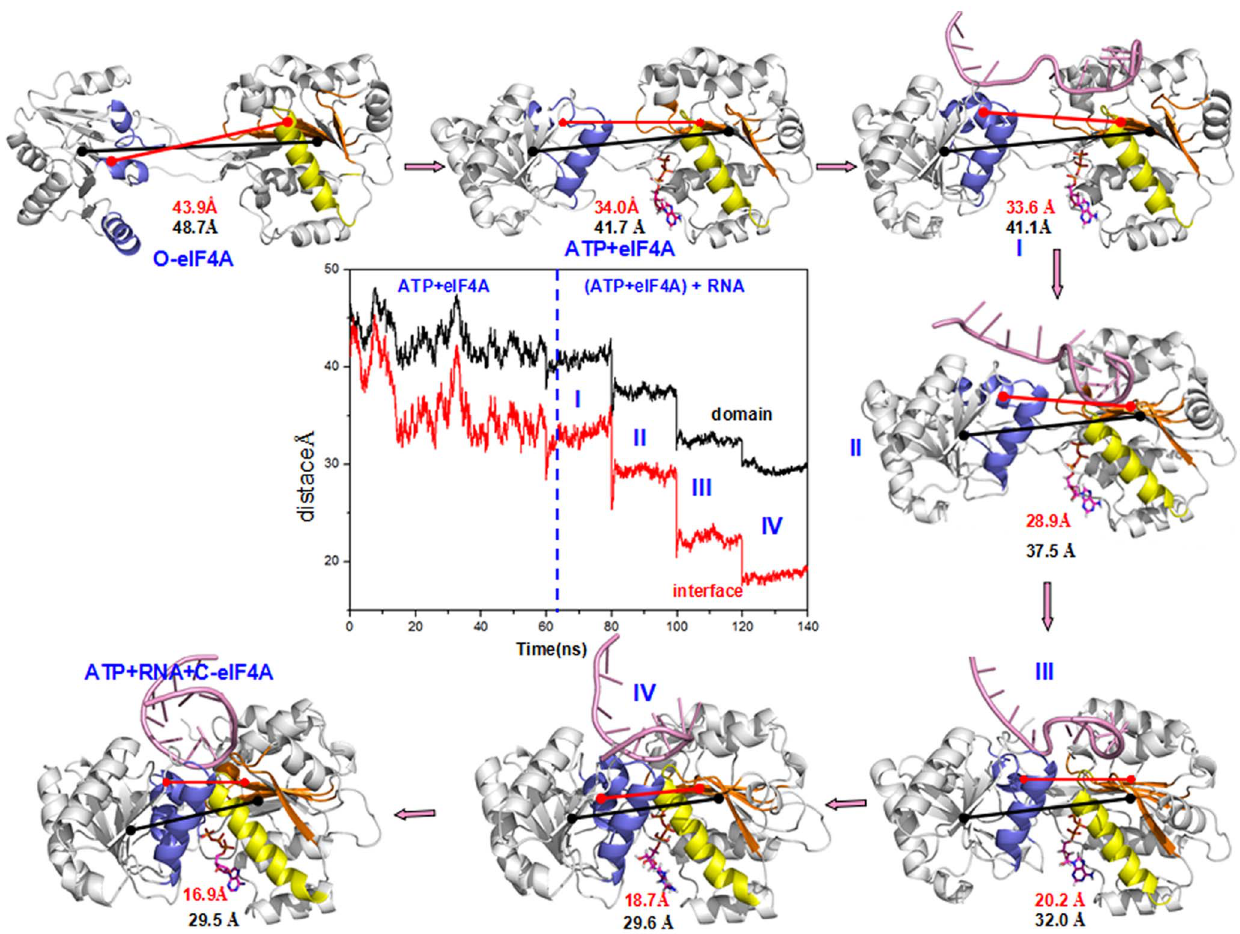
Figure 7. The structures of the allosteric process. The average structures are extracted from the trajectories of the O-eIF4A, ATP + eIF4A, I, II, III, IV and ATP + RNA + C-eIF4A models involved in the allosteric process of the ATP binding followed by RNA, i.e., the ATP + eIF4A model for the ATP first binding to the O-eIF4A model; the I-IV models for the RNA second binding to the equilibrium structure of the ATP + eIF4A model; the ATP + RNA + C- eIF4A model for the closed state of the eIF4A protein. The center image shows the time-dependence of the mass center distance between two domains (black), and that of N-domain – C-domain interface (red) during the simulation.